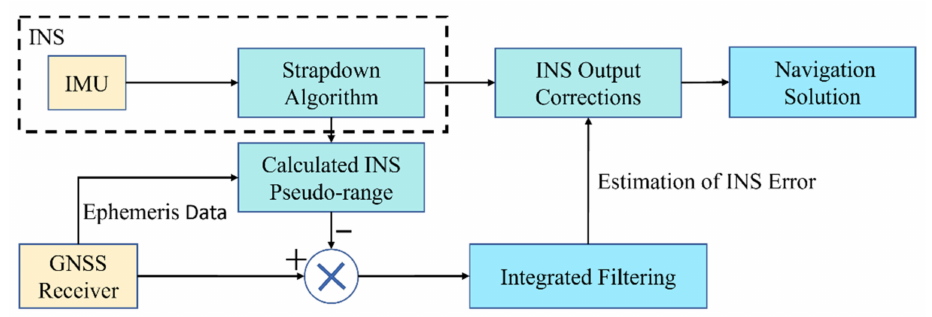
Figure 1. GNSS/INS tight integration